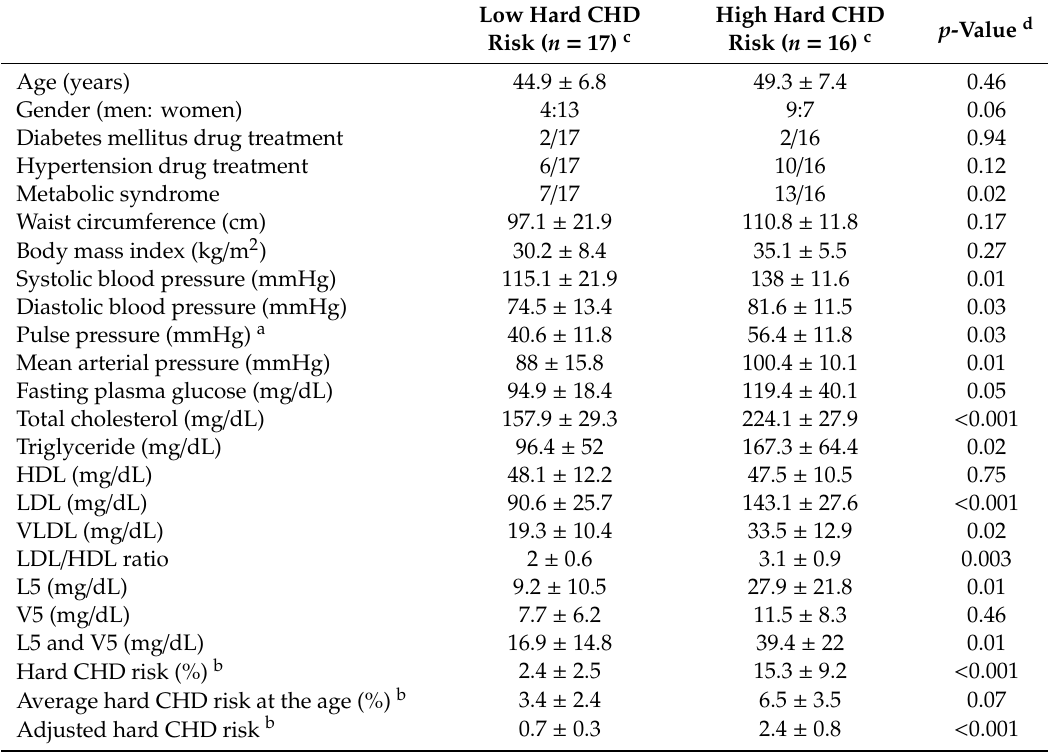
Table 1. Characteristics of study participants with high or low hard CHD